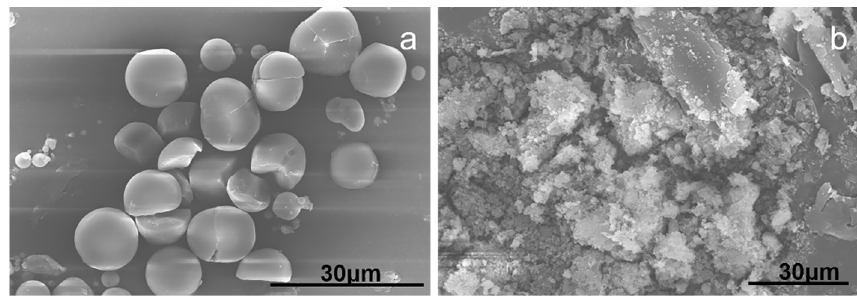
Figure A3. SEM images of fly ash ( a ) and activated fly ash ( b ).